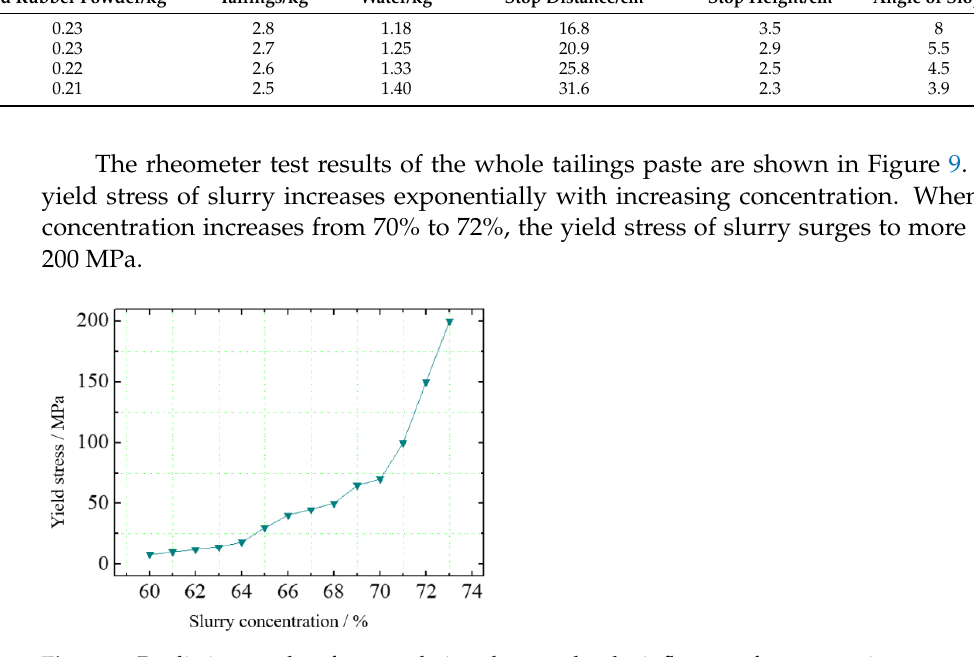
Table 1. Single layer flow test scheme and results.